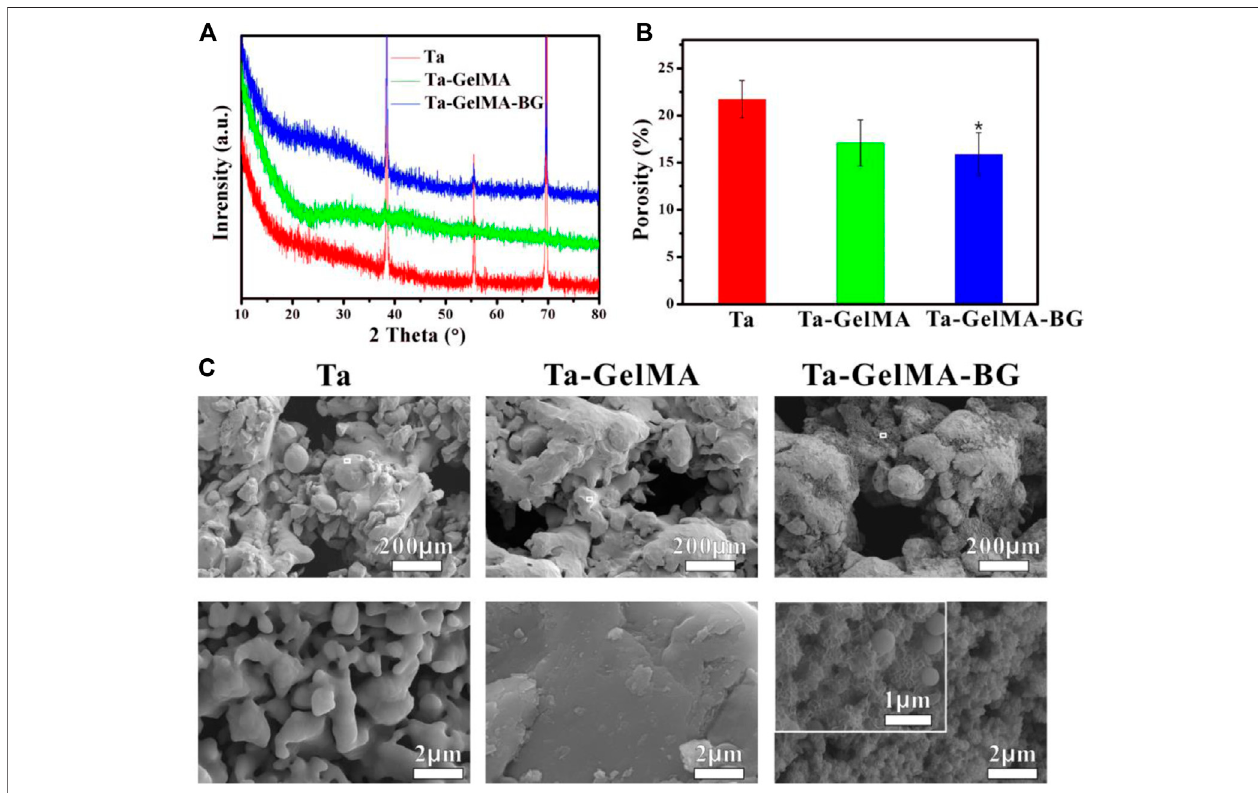
FIGURE 2 | Property evaluation of Ta – GelMA – BG scaffolds. (A) XRD pattern of the scaffolds. (B) Porosity of the scaffolds. (C) SEM images of the scaffolds after soaking in SBF for 7 days. (*) p < 0.05 vs Ta group.